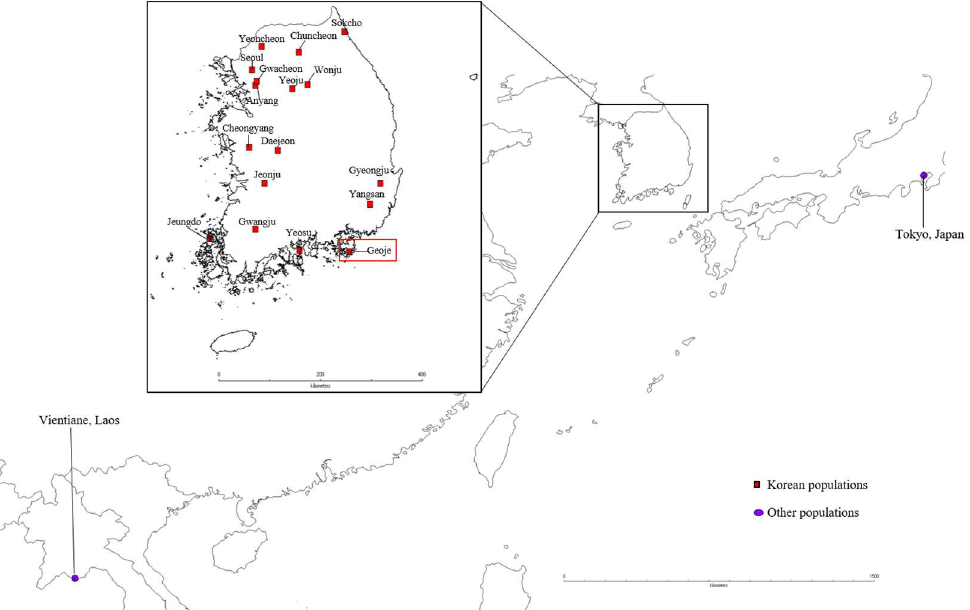
Figure 1. Sampling sites of Aedes albopictus in Korea, Laos, and Japan. Korean sampling locations ( n = 17) are marked by red squares, whereas Japan ( n = 1) and Laos ( n = 1) sample localities are marked by violet circles. A distribution map was created using DIVA-GIS (version 7.5, www.diva-gis.org accessed on 29 June 2021) on the basis of the locations’ geographic coordinates. Detailed sampling information is provided in Table